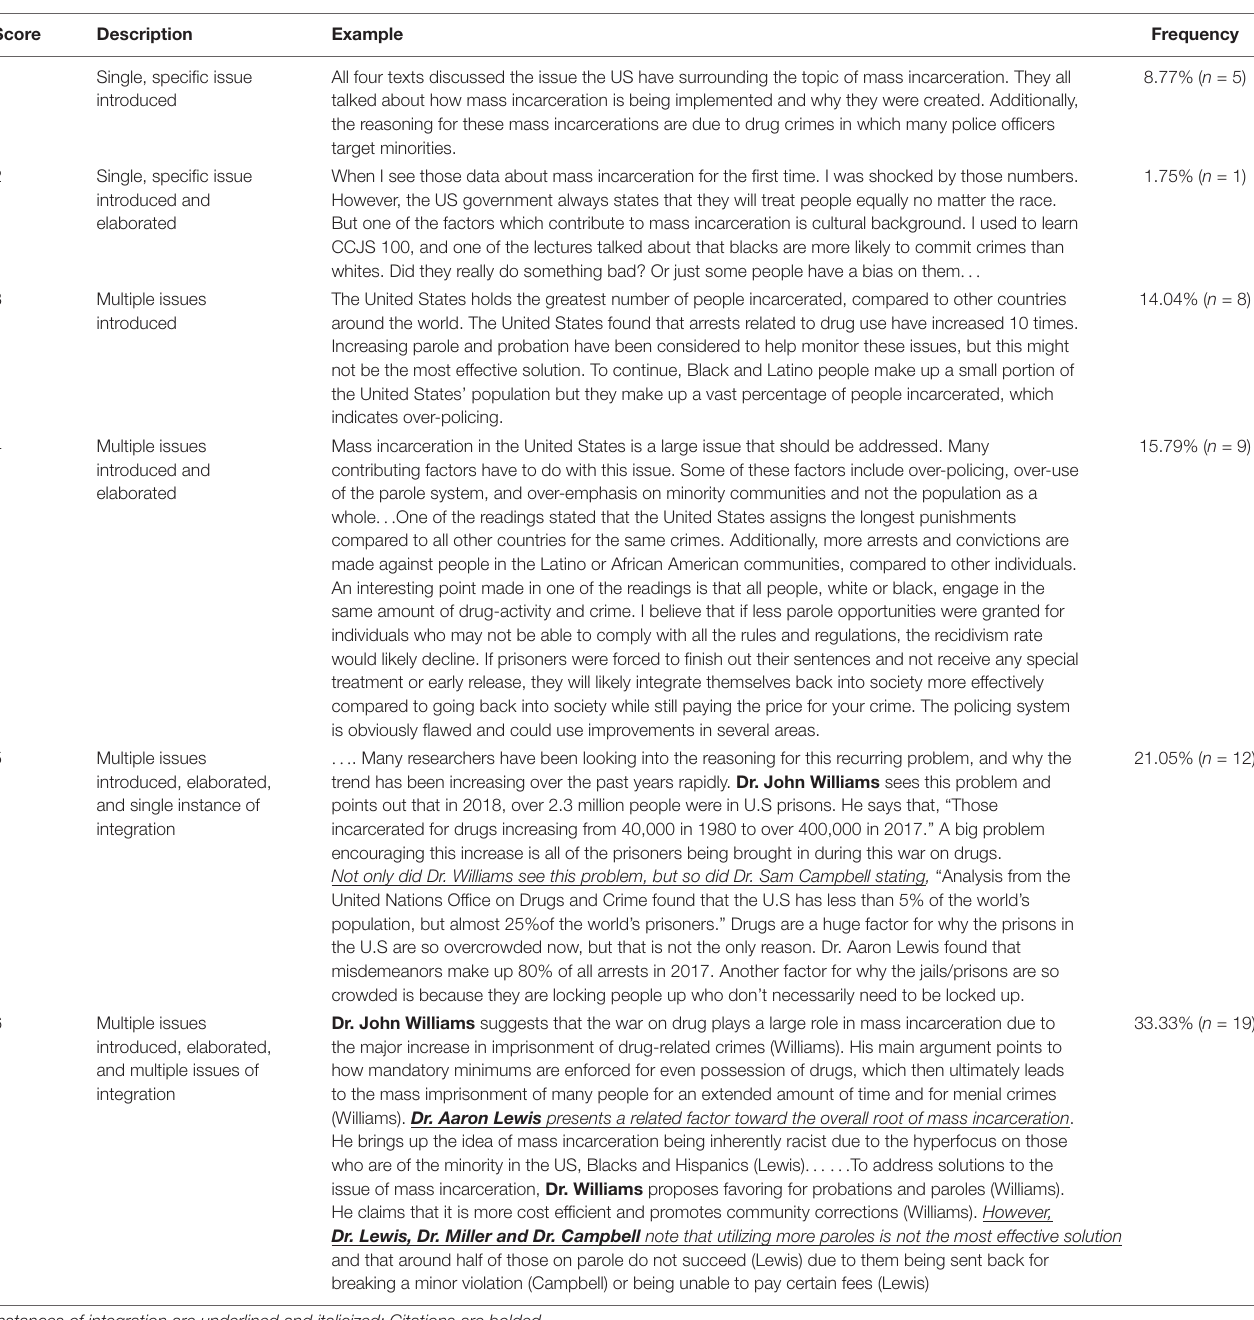
TABLE 3 | Rubric for scoring students’ research